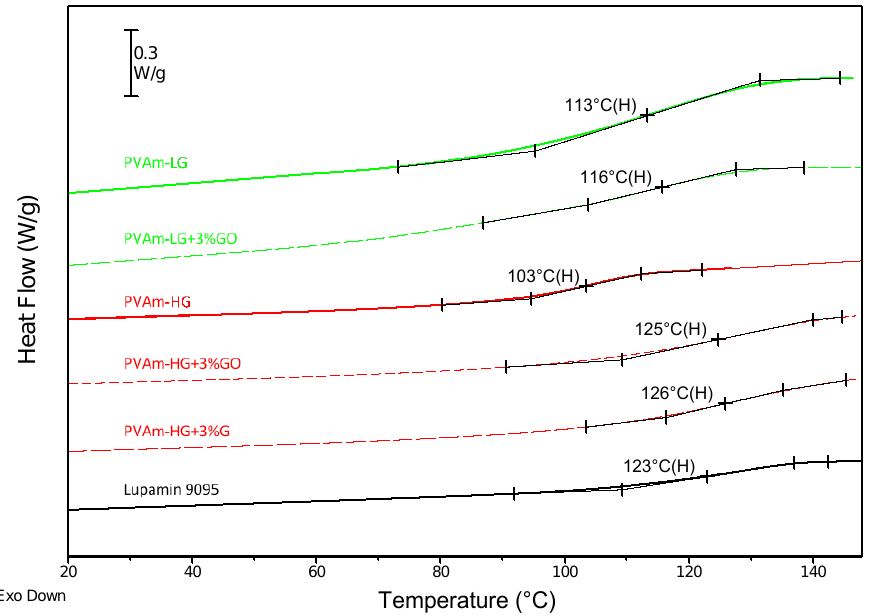
Figure 7. DSC curves of Lupamin 9095 and PVAm films at different degrees of purification, with and without G and GO. Temperatures in the chart refer to T g , which was calculated considering the maximum value of lines’ slopes, during the second order transition.